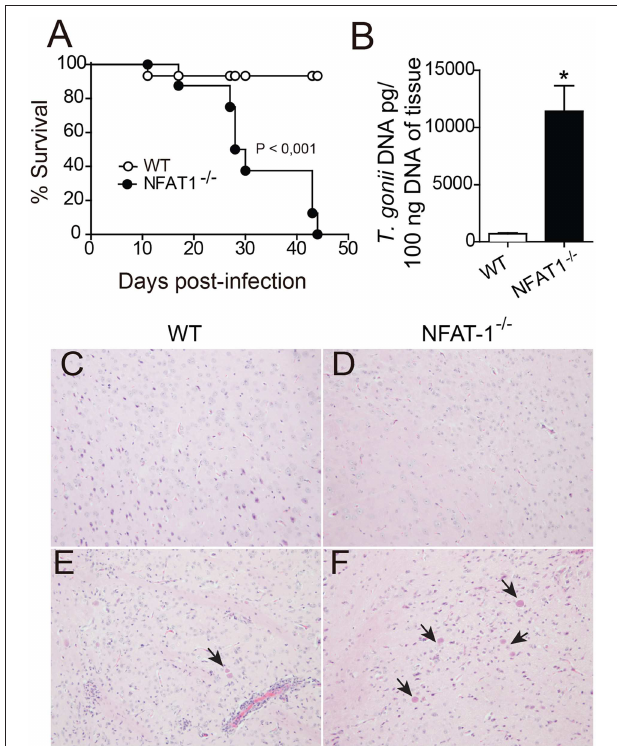
FIGURE 1 | NFAT1 deficiency leads to an increased susceptibility to infection with T. gondii . WT and NFAT1 − / − mice were infected orally with 100 cysts from the ME-49 strain of T. gondii . Survival was evaluated daily (A) . Data are the mean ± SEM of 8 animals per experimental group of two independent experiments (* p < 0.001). At 25 days post-infection (dpi), the central nervous system (CNS) ( n = 5 mice/group) was collected, the DNA of one hemisphere/mouse was extracted, and tissue parasitism was determined by qPCR based on a standard curve with T. gondii DNA (B) . Representative photomicrographs of CNS sections of WT (C,E) and NFAT1 − / − mice (D,F) , uninfected (top panel) and infected (bottom panel), stained with hematoxylin and eosin (H&E), are shown. Arrows indicate parasitophore vacuoles. Original magnification X200. Data are the mean ± SEM of the five mice per experimental group of two independent experiments (* P <